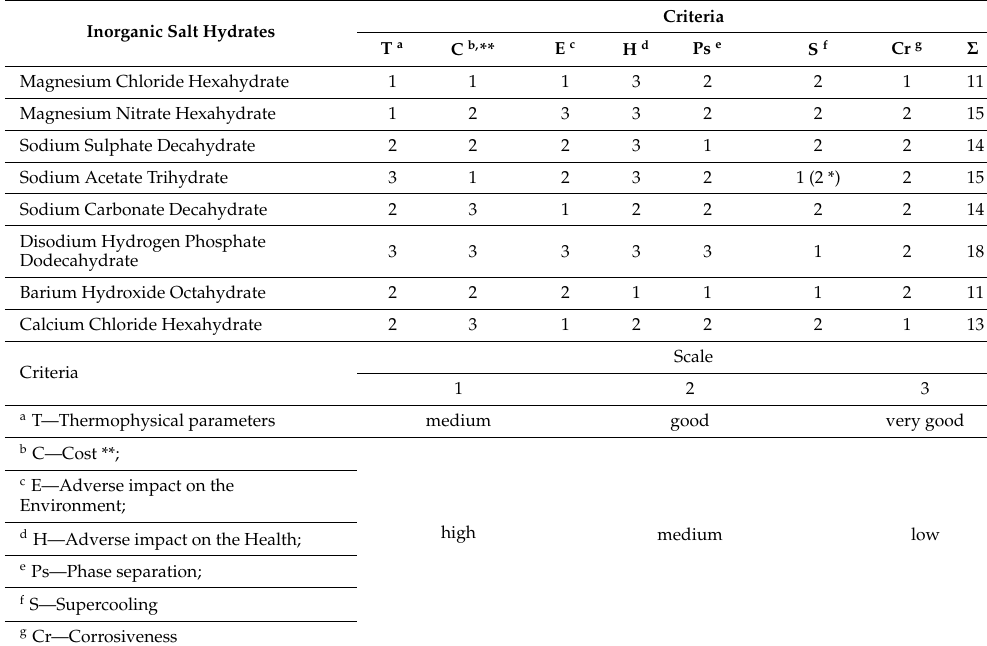
Table 5. Summary comparative analysis of 8 inorganic salt hydrates with a view of seven crucial